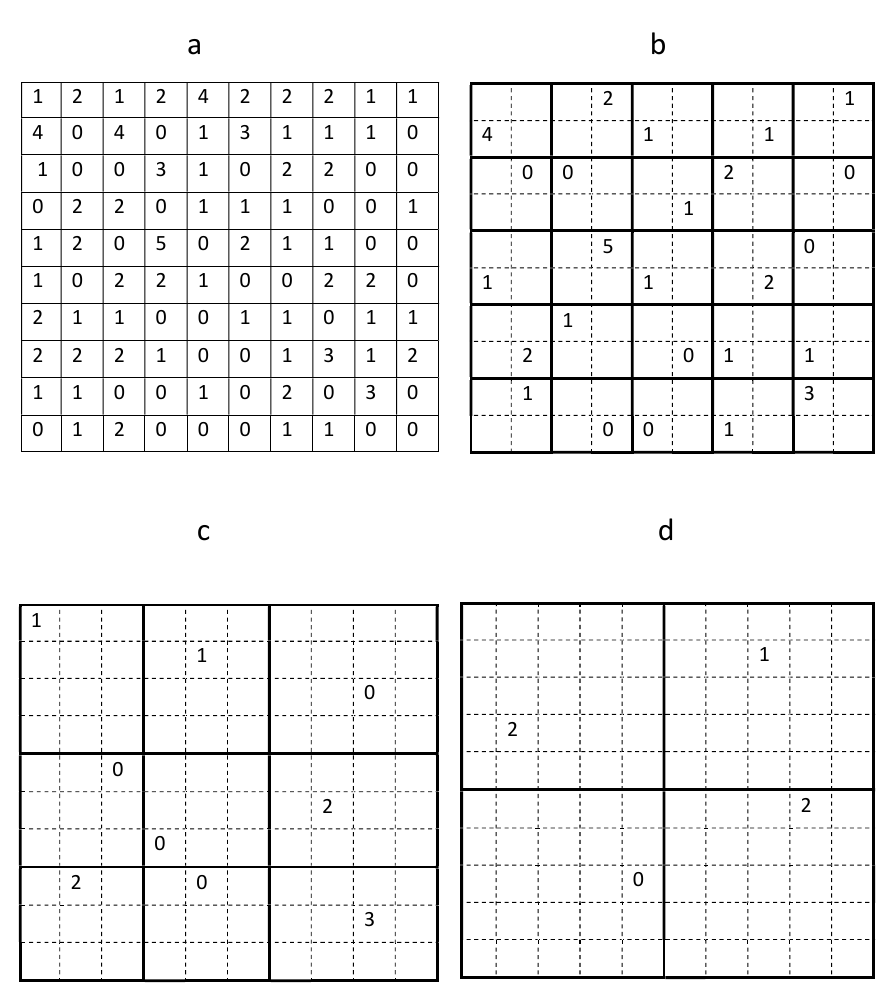
Figure 3. Generating a sequence of quasi-regular coarse sampling grids. Only one trap count is randomly selected with equal probability from each sub-domain on a coarse grid. The boundaries of each sub-domain on a coarse sampling grid are shown as bold lines (see details in the text). ( a ) The original sampling grid of N = 100 locations. ( b ) An example of trap counts randomly selected on a quasi-regular sampling grid of N = 25 locations. ( c ) A random choice of trap counts on a coarse grid of N = 9 locations. ( d ) A very coarse sampling grid where one trap count is randomly selected in each of four